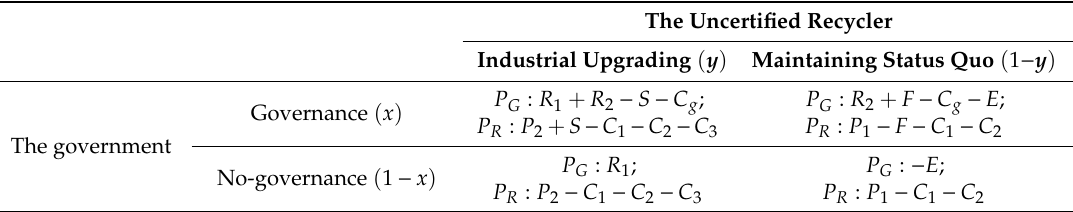
Table 2. The payo ff matrix in the evolutionary